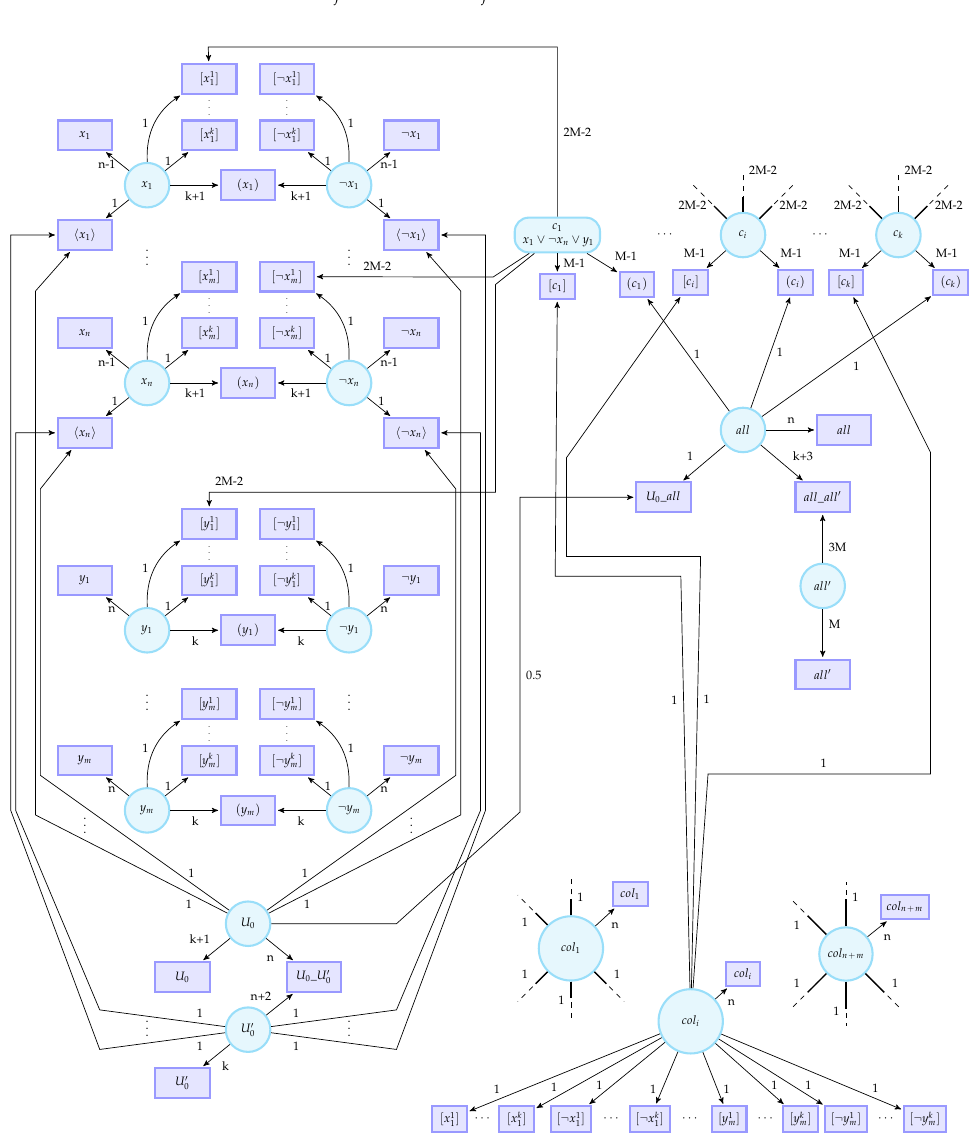
Figure 1. Scheme of the polynomial reduction.